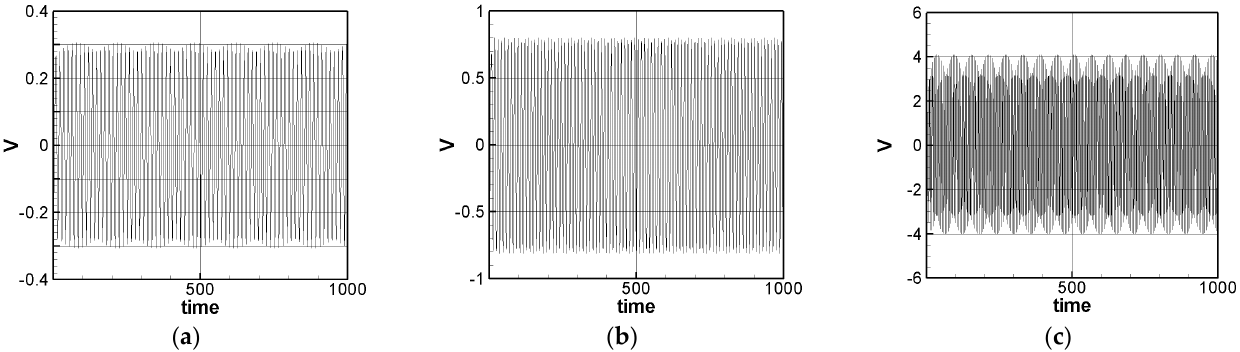
Figure 8. SES system theoretical voltage output (dimensionless). ( a ) 1st mode, ( b ) 2nd mode, and ( c ) 3rd mode.